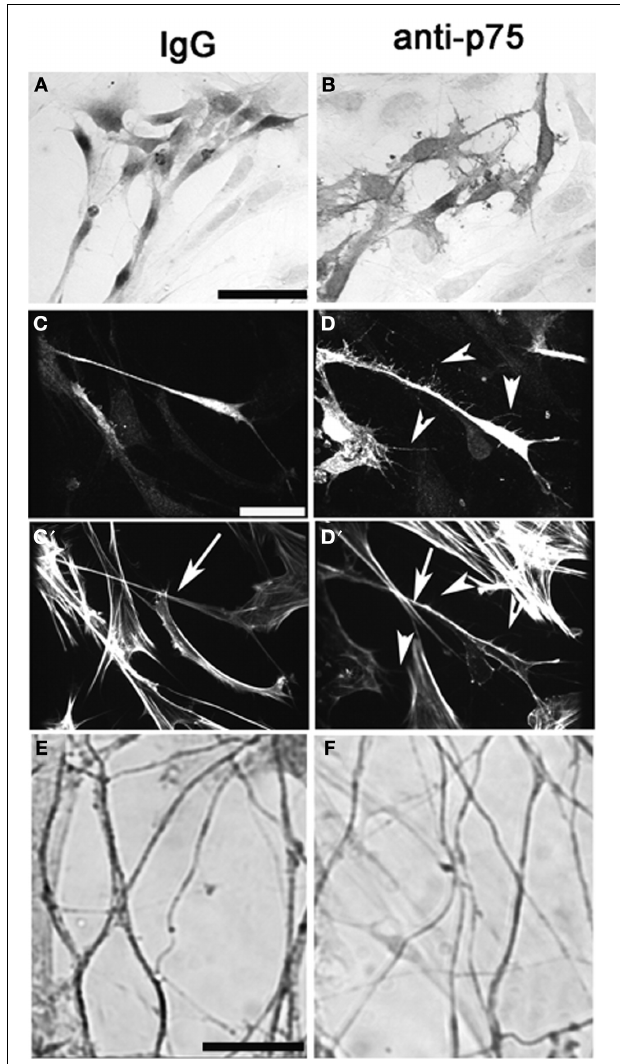
FIGURE 7 | Perturbation of p75NGFR signaling in vitro alters morphology of OECs and causes defasciculation of olfactory fibers. Nasal explants at 6div following treatment with p75NGFR blocking antibody (1:6000, B,D,F ) and with rabbit IgG mock, 1:6000, (A,C) , Explants were immunocytochemically-stained for S-100 (A,B) , S-100 and Phalloidin (C,D) or peripherin (E,F) . (A–D) Disruption of p75NGFR signaling alters morphology of OECs The morphology of S100-positive cells located distal to the explant’s tissue mass were larger, flatter, and exhibit more processes and neurites (B,D) as compared to control group (A,C) . Staining for actin (phalloidin) revealed that these processes had sparse actin filaments ( D (cid:3) , arrowheads). OECs in the treated group also appeared to have denser cortical actin along the axis of the cell body ( C (cid:3) vs. D (cid:3) , arrow). Finally, disruption of p75NGFR increased olfactory fiber branching and decreased the optical density of peripherin-positive fibers, suggesting defasciculation had occurred. Scale bars: = 250 μ